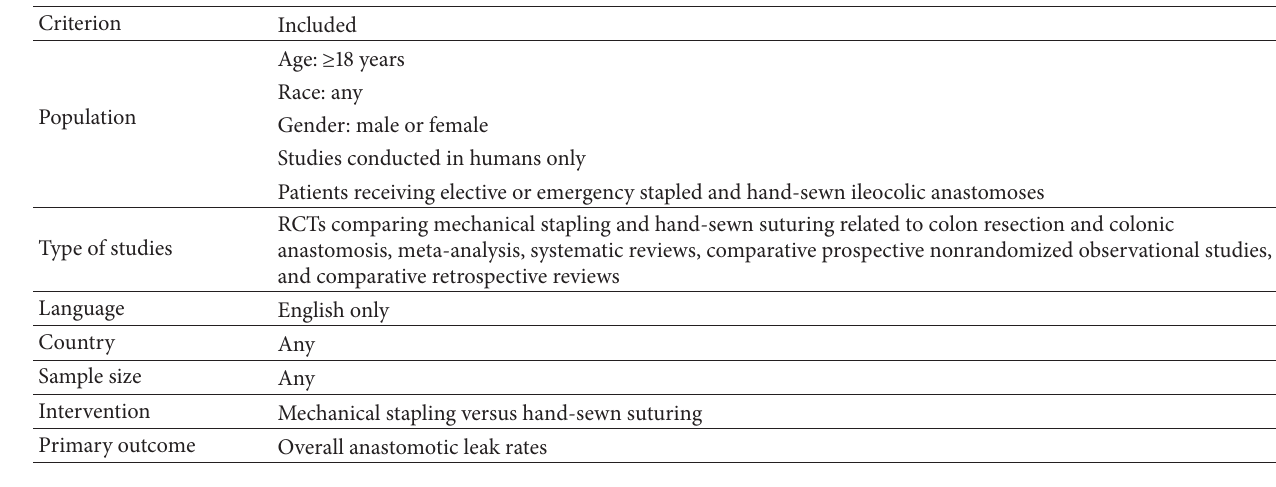
Table 1: Study inclusion criteria for the systematic review and